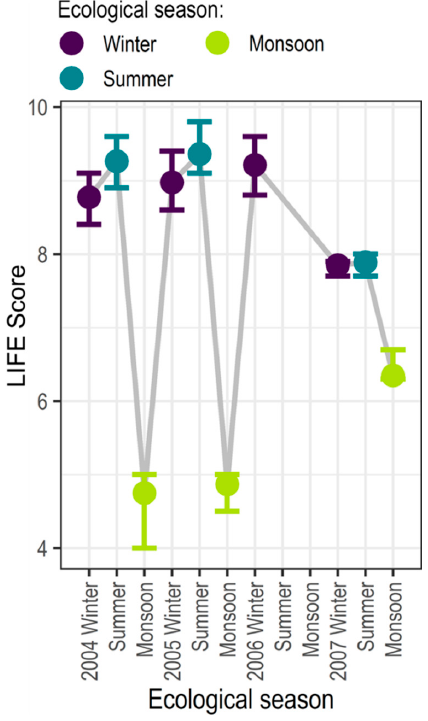
Figure 5. Observed average seasonal LIFE scores across all sites for the period 2004–2007 (hydrological years); error bars indicate the minimum and maximum LIFE scores observed.